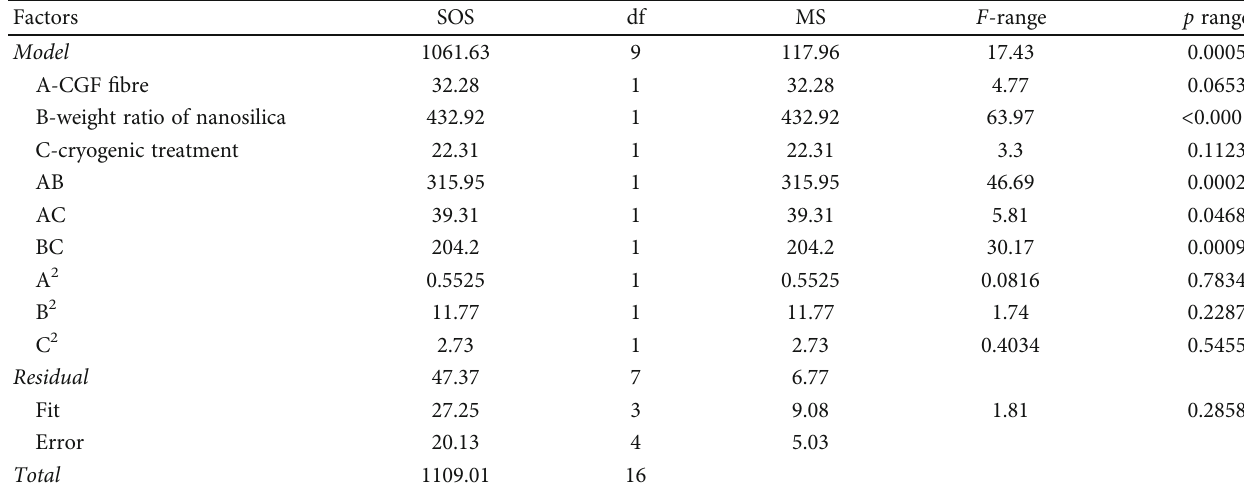
Table 3: ANOVA for tension behaviour.